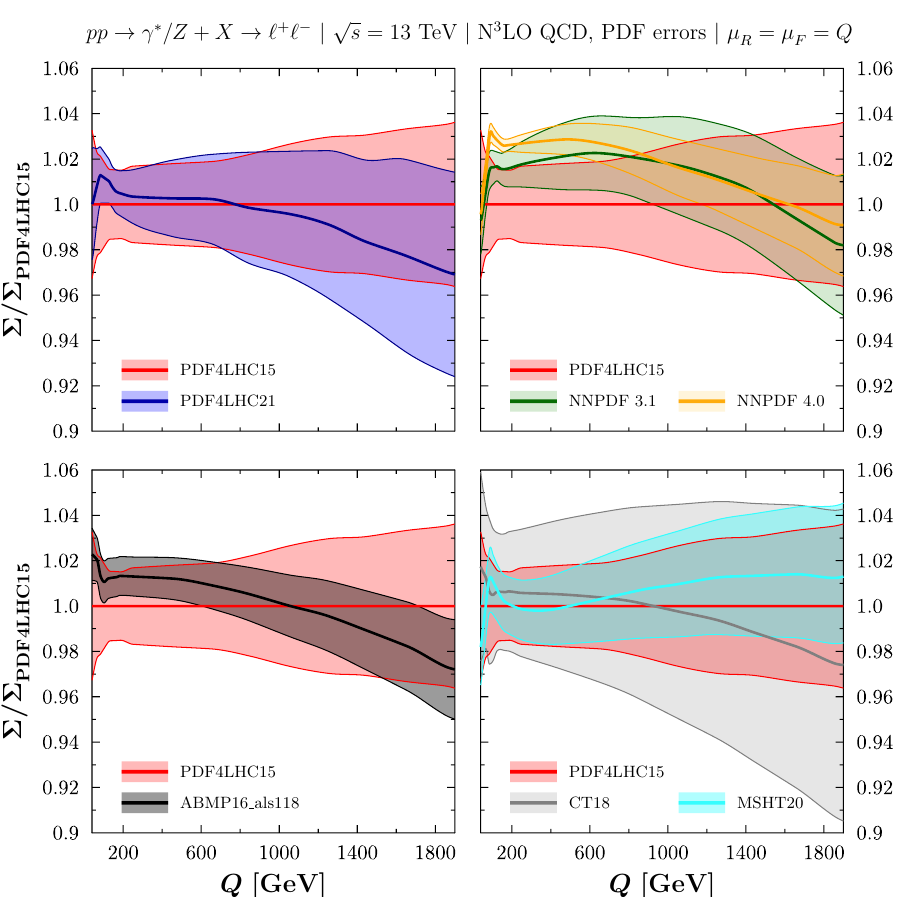
Figure 12 . Dependence on the choice of the PDF set of the neutral-current Drell-Yan differential cross section at N 3 LO in QCD as a function of the invariant mass Q of the final-state lepton pair, at the 13 TeV LHC. The results are normalized to the central PDF4LHC15 PDF set and the 68% CL PDF uncertainties are represented by bands for all sets and calculated according to the prescription of ref. [67]. The comparison is between PDF4LHC15 and: PDF4LHC21 (upper left panel); NNPDF 3.1 and NNPDF 4.0 (upper right panel); ABMP16_als118 (lower left panel); CT18 and MSHT 20 (lower right